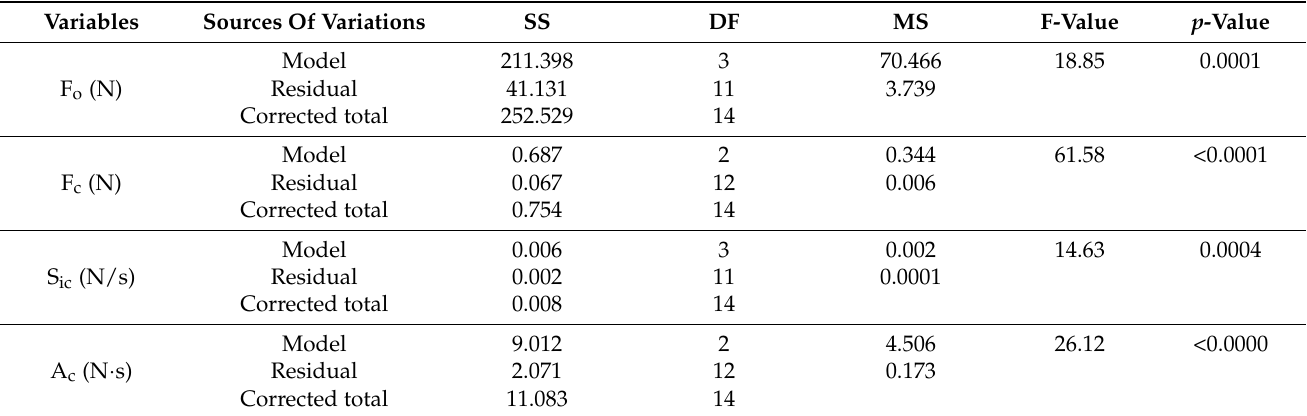
Table 3. Analysis of variance of response surface